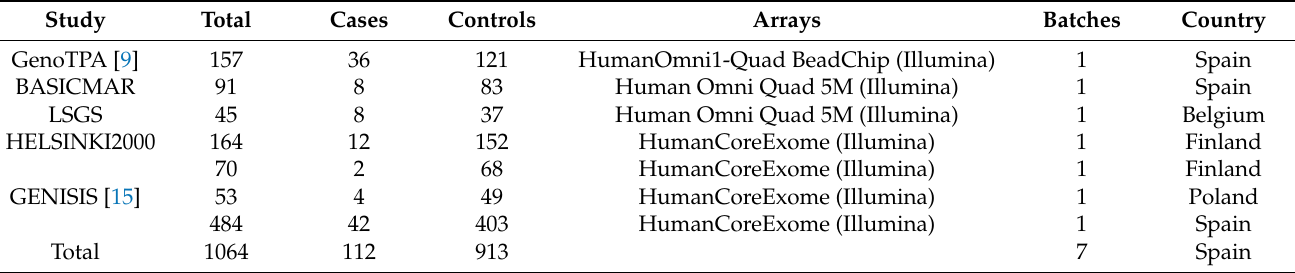
Table 2. Replication